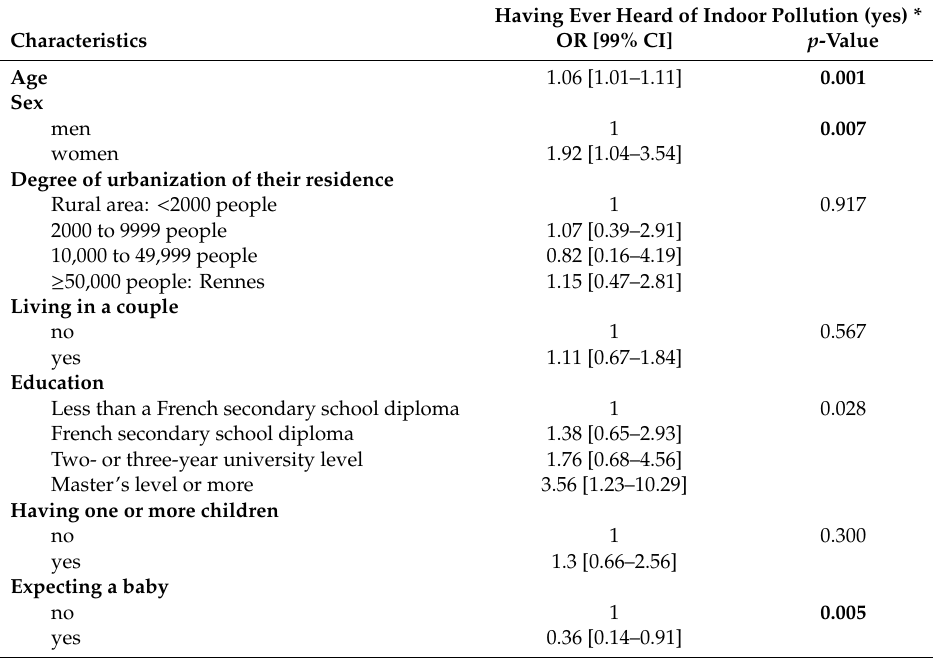
Table 2. Having already heard of indoor pollution according to socio-demographic characteristics ( n =